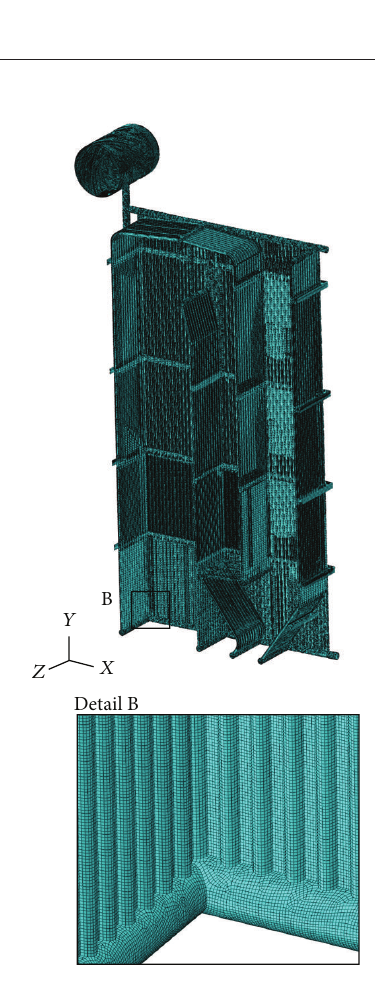
Figure 9: Finite element mesh-calculation model